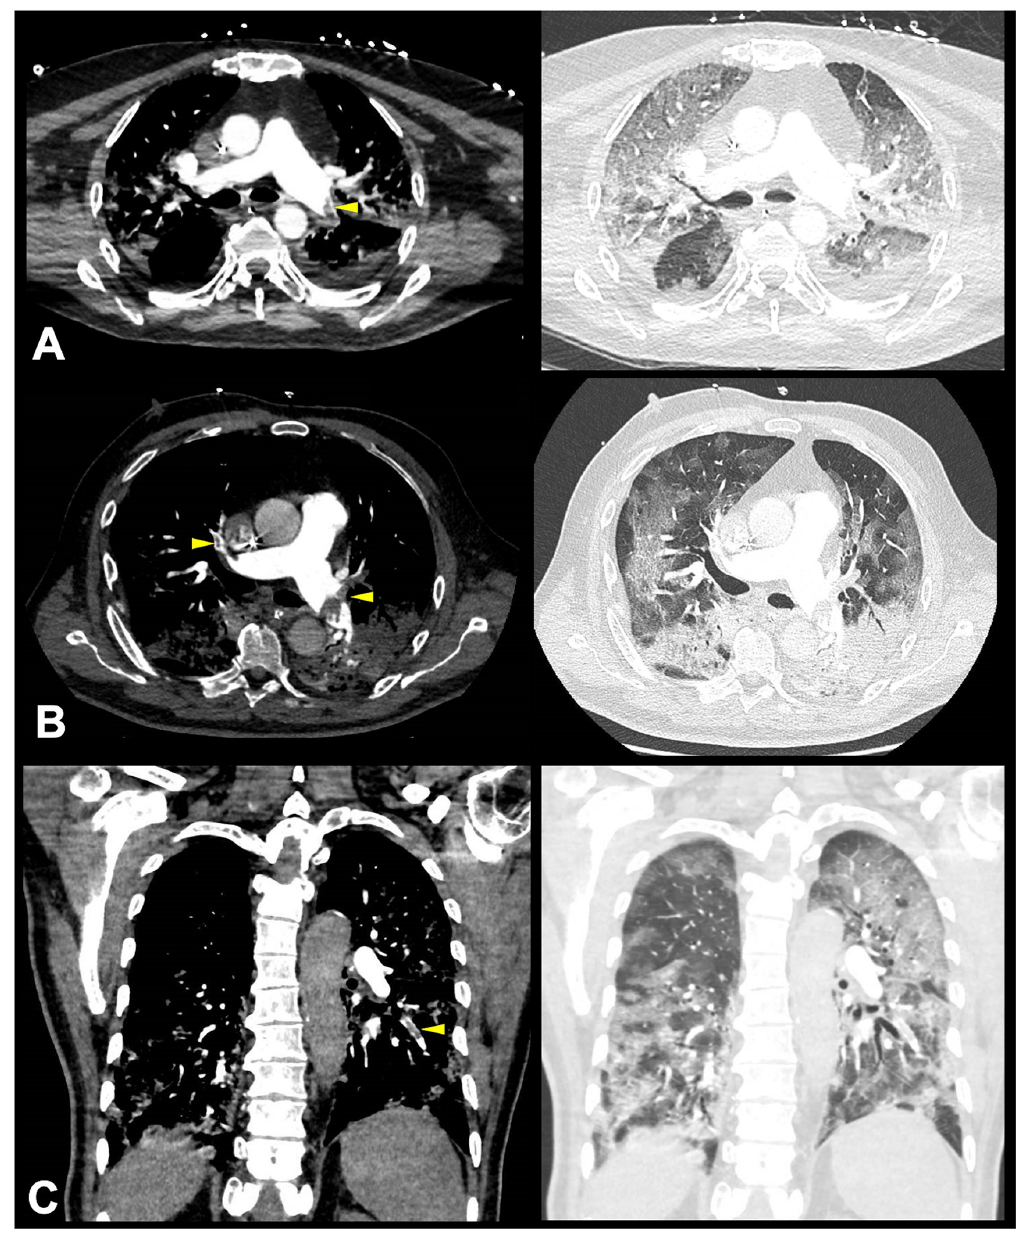
Fig 1. Pulmonary embolism or thrombosis in ARDS COVID-19 patients. Illustrative examples of Computed Tomography Pulmonary Angiography revealing intraluminal defects (left side, yellow arrowhead) and associated parenchymatous condensations (right side) in the left lower pulmonary artery in a 73-year-old patient at day 5 after ICU admission (Panel A), in the main left pulmonary artery and in the anterior segmental pulmonary artery of the right upper lobe in a 73-year-old patient at day 4 after ICU admission (Panel B) and in a segmental pulmonary artery of the left lower lobe (coronal view) in a 65-year-old patient at day 3 after ICU admission (Panel C).